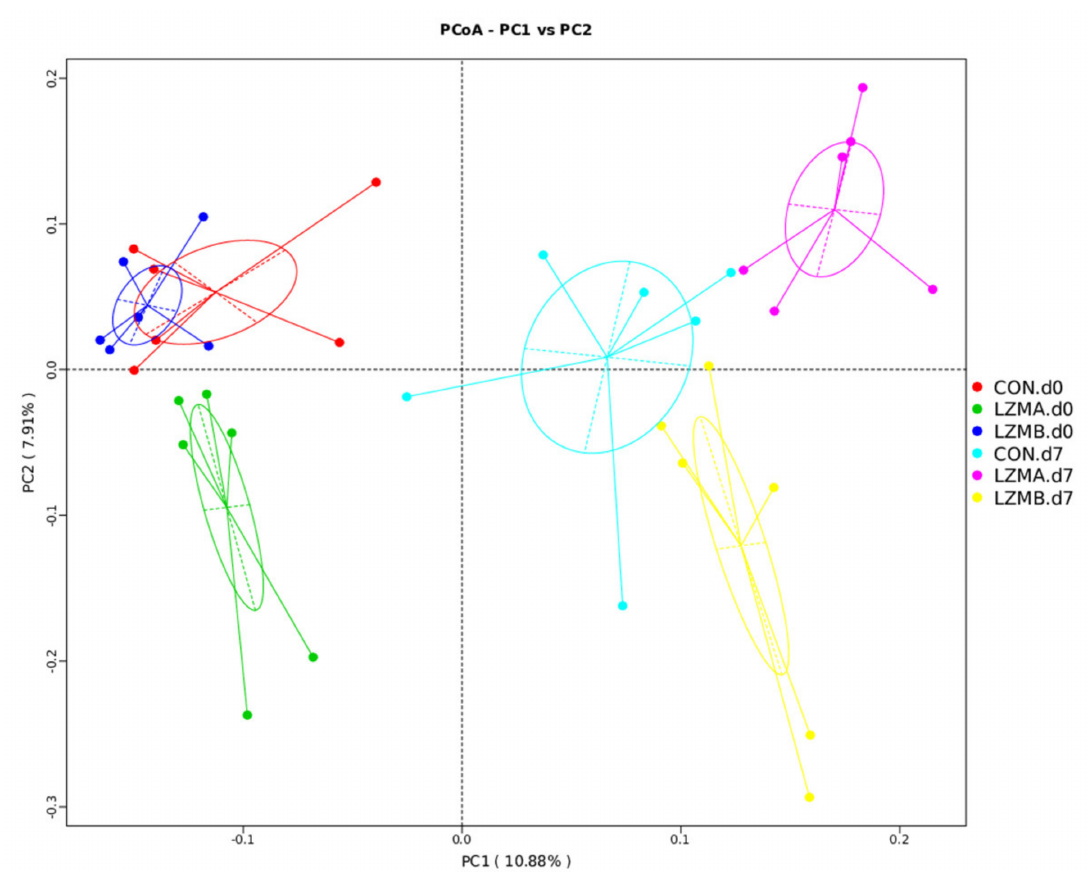
Figure 2. Comparison of the vaginal microbiota composition among treatments. Principal coordinate analysis to visualize the binary jaccard distances of vagina samples from individual sow. CON. d0 = control diet at the day of farrowing, CON. d7 = control diet at day 7 of lactation, LZMA d0 = control diet + lysozyme 150 mg/kg at the day of farrowing, LZMA d7 = control diet + lysozyme 150 mg/kg at day 7 of lactation, LZMB d0 = control diet + lysozyme 300 mg/kg at the day of farrowing, LZMB d7 = control diet + lysozyme 300 mg/kg at day 7 of